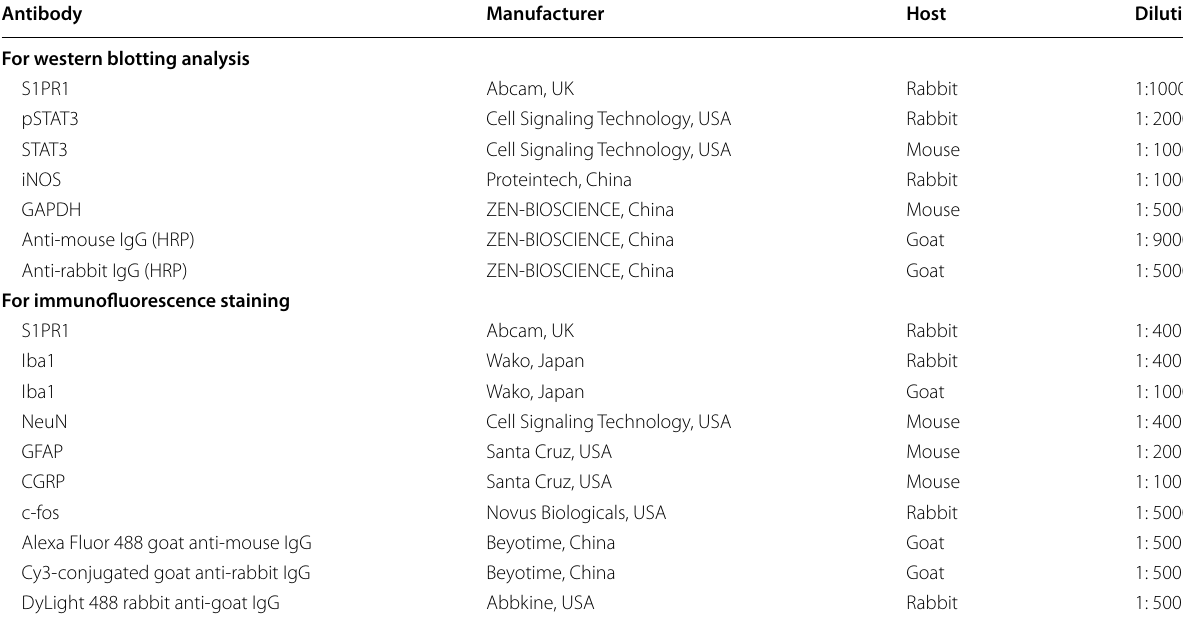
Table 1 All antibodies used in western blotting and immunofluorescence staining Antibody Manufacturer Host For western blotting analysis S1PR1